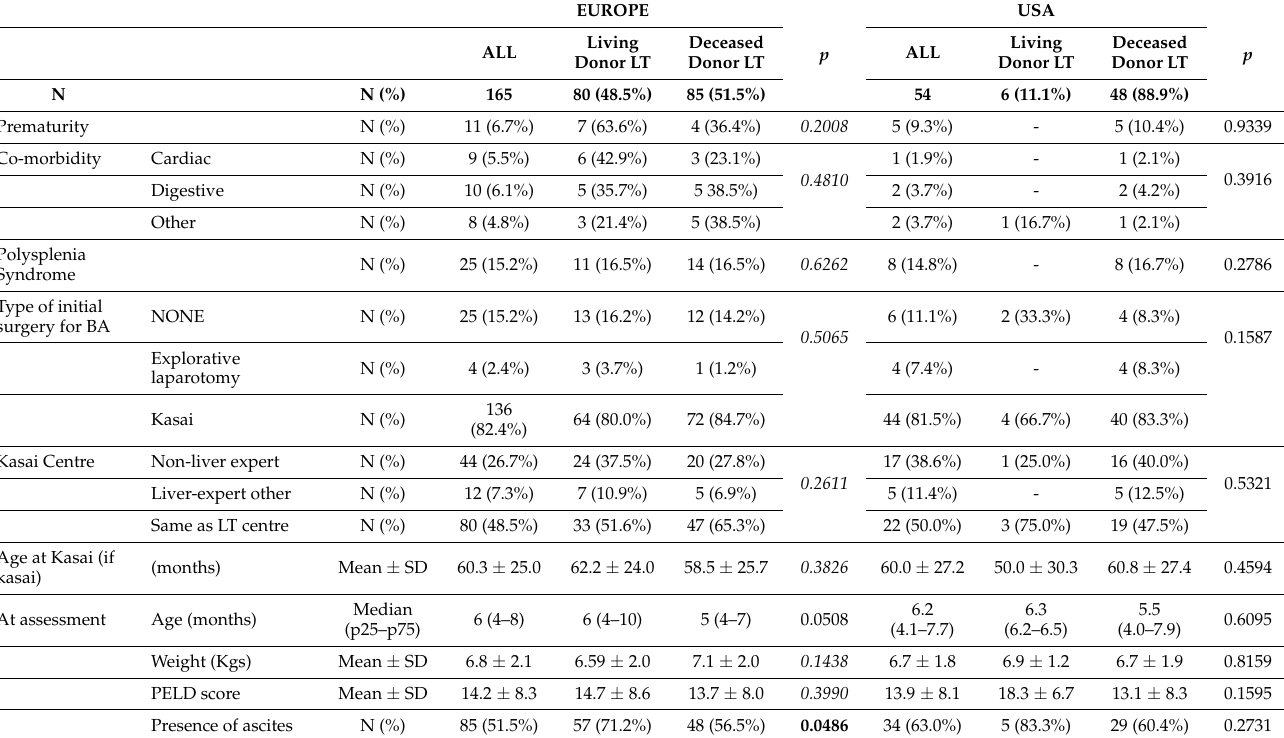
Table 3. Demographics, data and outcomes of transplanted patients according to type of